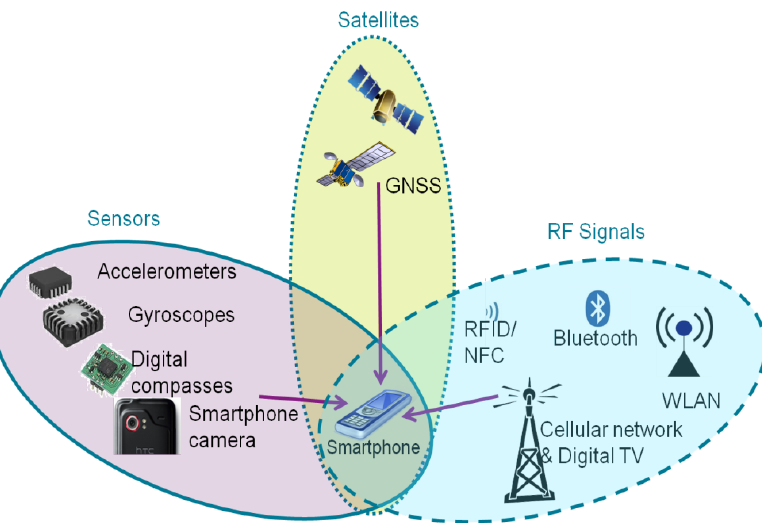
Figure 1. Three families of smartphone-based positioning